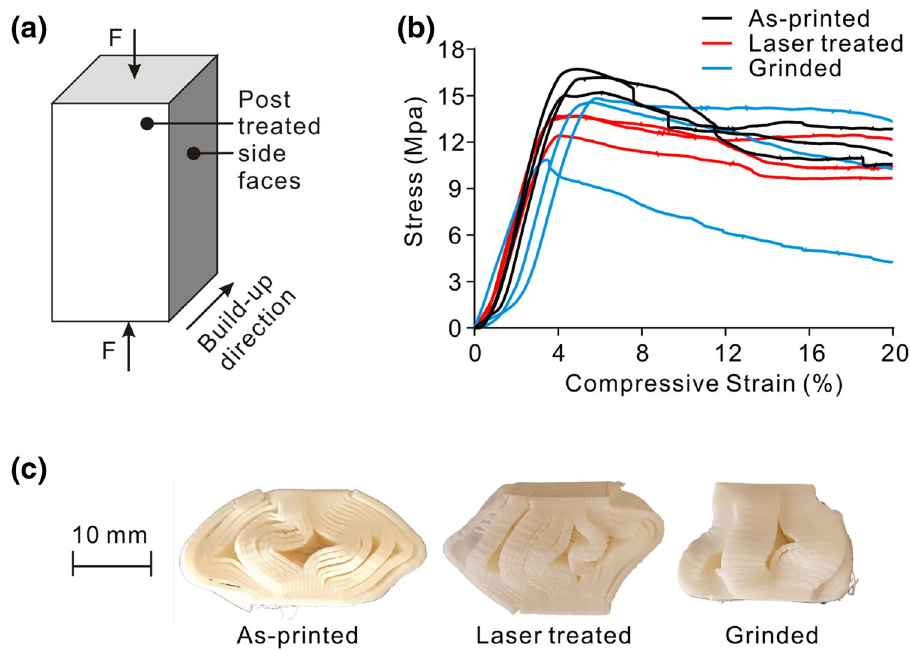
Fig. 4 Compression test. a Schematic of compression test; b stress–strain curves of FDM specimens with different post processing; c Different com- pressive break morphology of specimens before and after post treatment. More cracks were generated on rougher surface at layer bonding area. Cracks were evenly distributed between